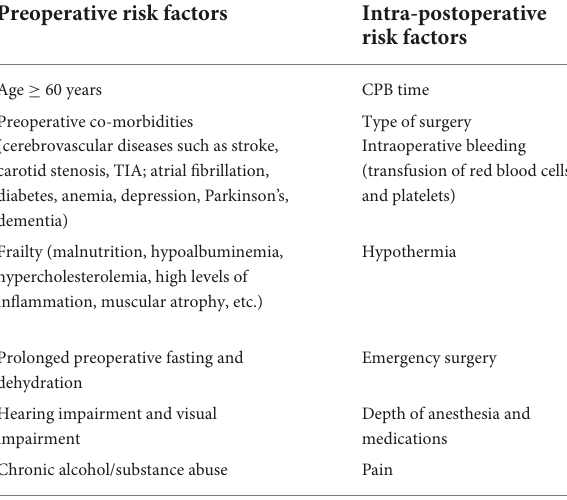
TABLE 2 Perioperative risk factors for delirium after cardiac